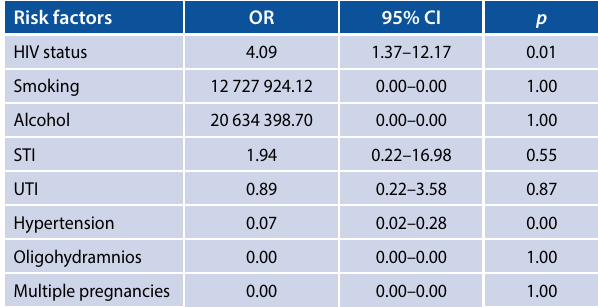
Note: CI: confidence interval, HIV: human immunodeficiency virus, OR: odds ratio, STI: sexually transmitted infection, UTI: urinary tract